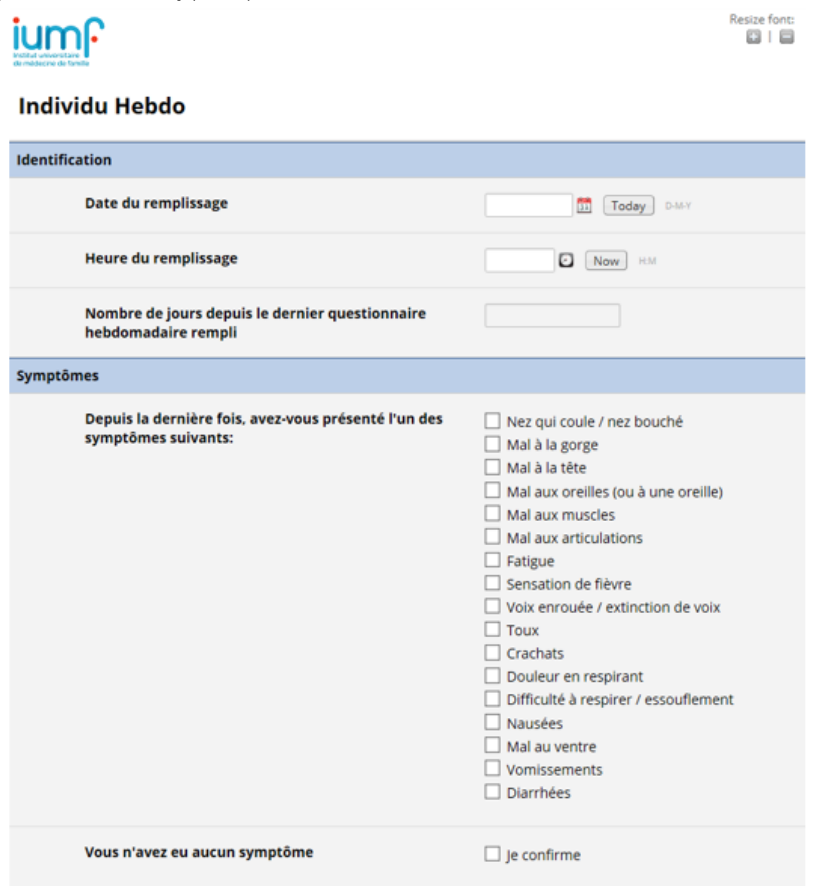
Figure 2. Weekly online questionnaire for study